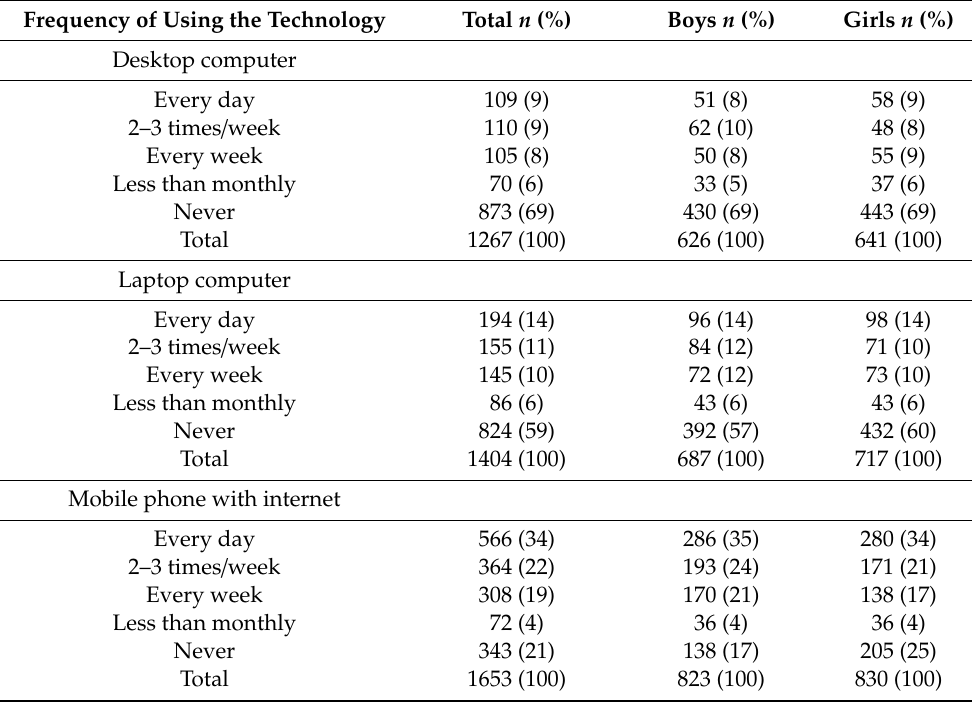
Table 2. Number and percentage of respondents who responded to the following question: “What kind of information technology do you generally use?”, by gender. Adolescents attending schools in Bissau, June